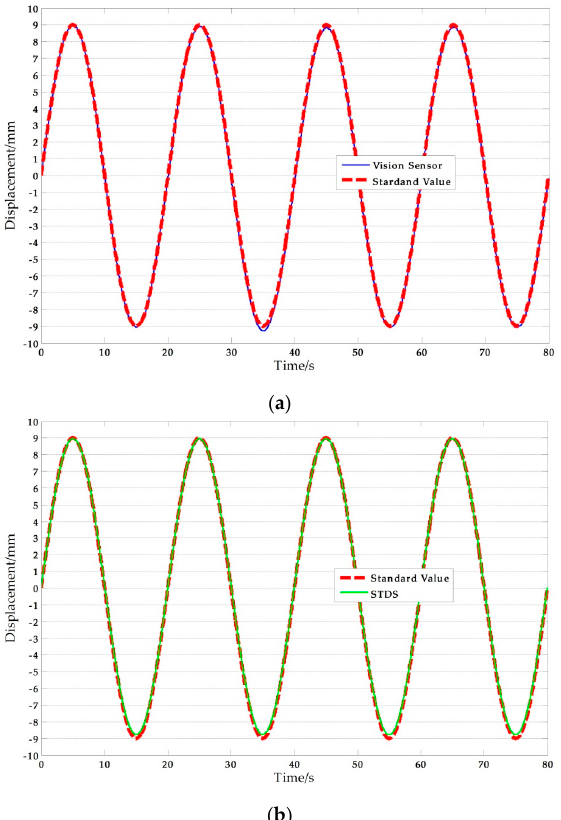
Figure 11. Artificial measurement comparisons: ( a ) Measurement results of vision-sensor compared with standard values; ( b ) Measurement results of STDS compared with standard values. ( f = 0.05 Hz, A = 9 mm). Table 9. NRMSE analysis of artificial target experimental results.